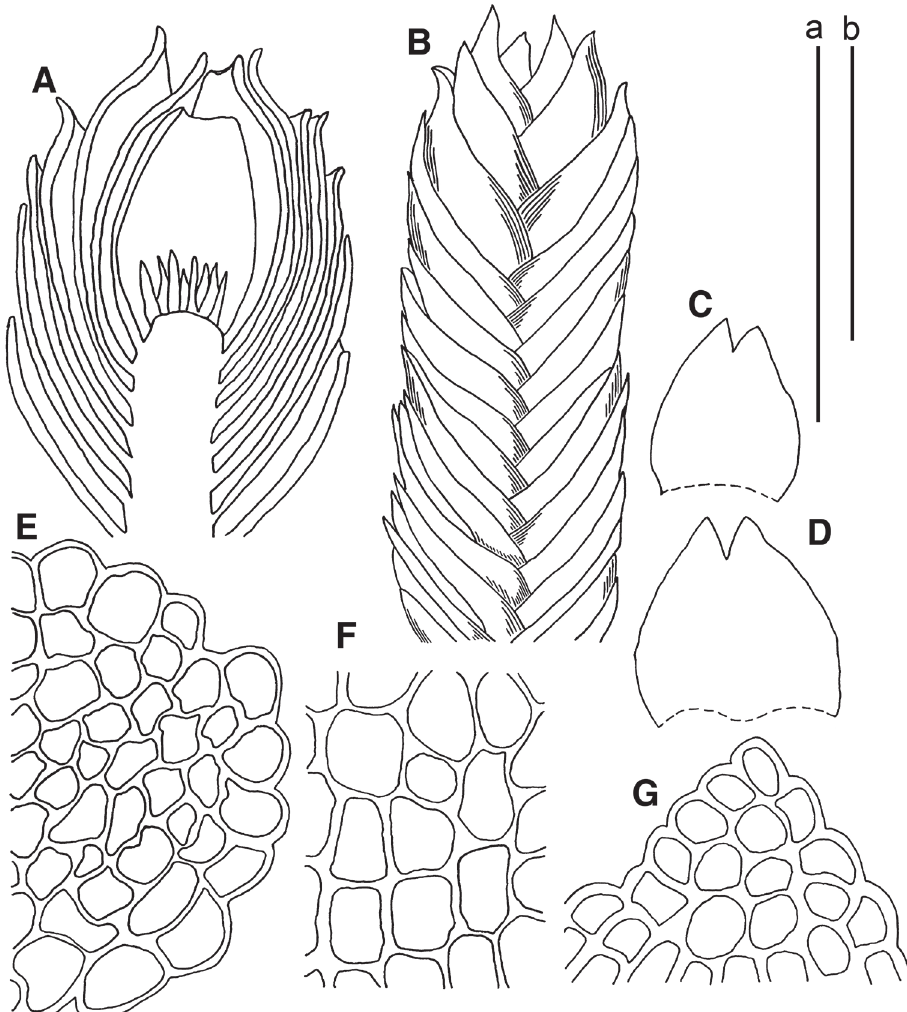
Figure 9. Gymnomitrion faurianum (Steph.) Horik. A gynoecium longitudinal section B plant habit C, D leaves E stem cross section (fragment) F midleaf cells G cells in leaf lobe apex. Scale bars: a 1 mm ( A–D ); b 100 μm ( E–G